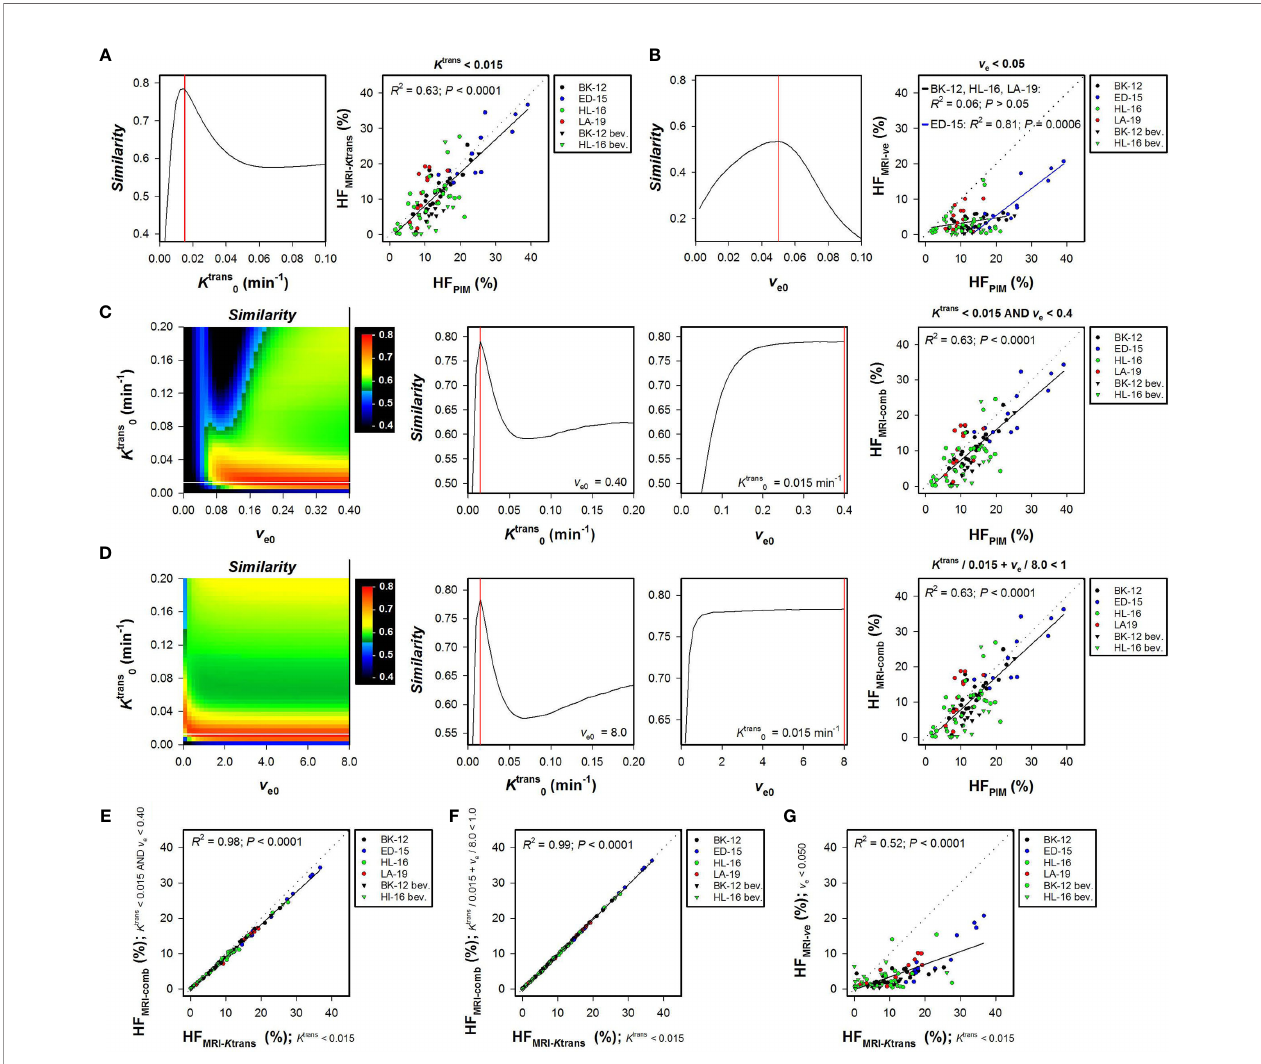
FIGURE 1 | Hypoxic fractions were calculated from K trans maps alone (HF MRI- K trans ), v e maps alone (HF MRI- v e ), or by combining K trans and v e maps (HF MRI-comb ), and were compared with hypoxic fractions assessed by immunohistochemistry using pimonidazole as a hypoxia marker (HF PIM ) in untreated and bevacizumab-treated (bev) BK-12, ED-15, HL-16, and LA-19 cervical carcinoma xenografts. Voxels were de fi ned as hypoxic if K trans < K trans 0 (A) , v e < v e0 (B) , K trans < K trans 0 and v e < v e0 (C) , or K trans = K trans 0 + v e / v e0 < 1 (D) , where K trans 0 and v e0 were threshold values for K trans and v e respectively. (A) The Similarity between HF MRI- K trans and HF PIM versus K trans 0 , and HF MRI-Ktrans versus HF PIM for individual tumors using the optimal K trans 0 . (B) The Similarity between HF MRI- v e and HF PIM versus v e0 , and HF MRI- v e versus HF PIM for individual tumors using the optimal v e0 . (C, D) Color-coded images of the Similarity between HF MRI-comp and HF PIM for combinations of K trans 0 and v e0 , the Similarity between HF MRI-comp and HF PIM versus K trans 0 for the optimal v e0 , the Similarity between HF MRI-comp and HF PIM versus v e0 for the optimal K trans 0 , and HF MRI-comp versus HF PIM for individual tumors using the optimal combination of K trans 0 and v e0 . The optimal K trans 0 and v e0 are indicated by white and black lines respectively in the color coded Similarity images, and the Similarity scale is given by the color bar. (E – G) , HF MRI-comp versus HF MRI- K trans (E, F) , and HF MRI- v e versus HF MRI- K trans (G) . Points represent individual tumors, solid black lines were fi tted to the data by linear regression analysis, and dotted lines show the one-to-one correlation line (A – G) . Solid red lines indicate the optimal K trans 0 and the optimal v e0 (A – D) and HF PIM was only found for the ED-15 tumors implying that this strategy will have limited application ( Figure 1B ; R 2 = 0.81 and P = 0.0006 for ED-15 tumors; R 2 = 0.06 and P > 0.05 for BK-12, HL-16, and LA-19 tumors).